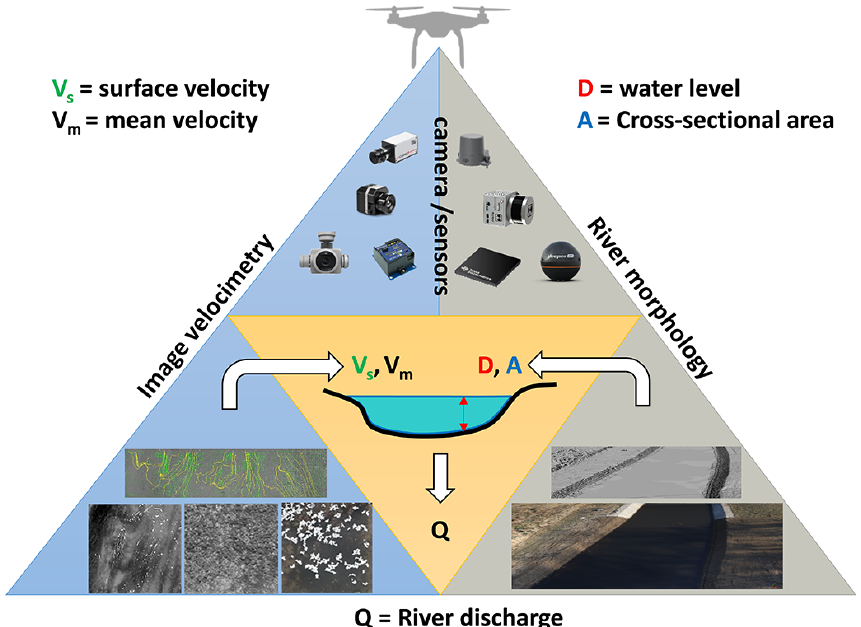
Figure 5. Adapted from Dal Sasso et al. (2021b). Potential in the use of UAS (unmanned aircraft system) for river monitoring combining river morphological and surface velocity estimations. The combinations of different sensors (e.g. RGB or TIR – thermal infrared – camera, lidar, echo sounder, etc.) may help to measure flow at bridges in different fields and flow